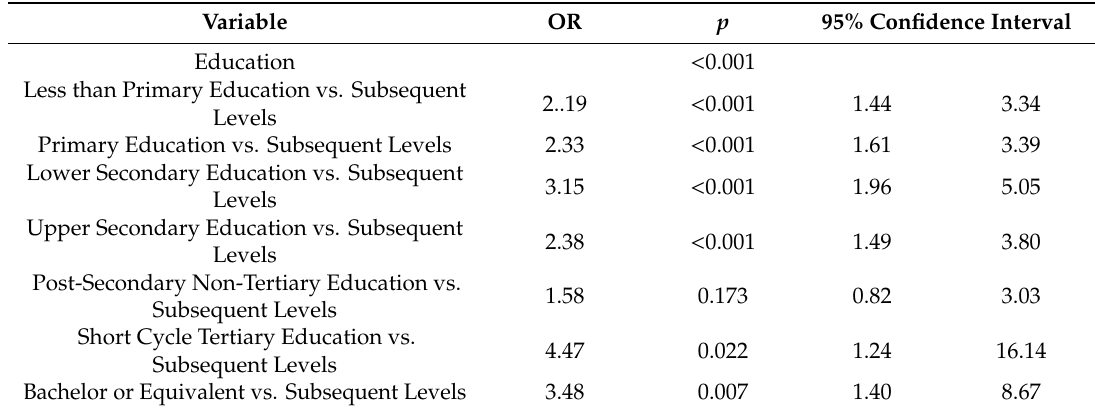
Table 8. Second model (logistic regression